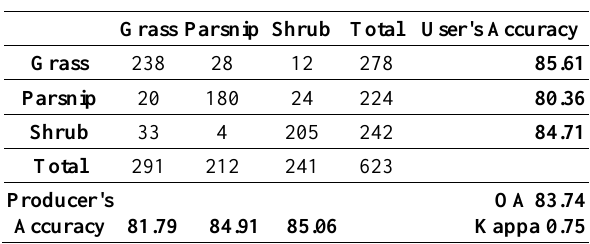
Table 6. Error matrix for accuracy assessment at Image Resolution 0.1